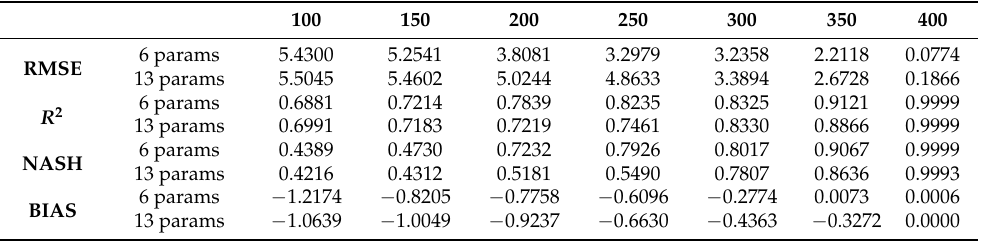
Table 4. Statistical results for different parameters and various sampling sizes based on the six-floor